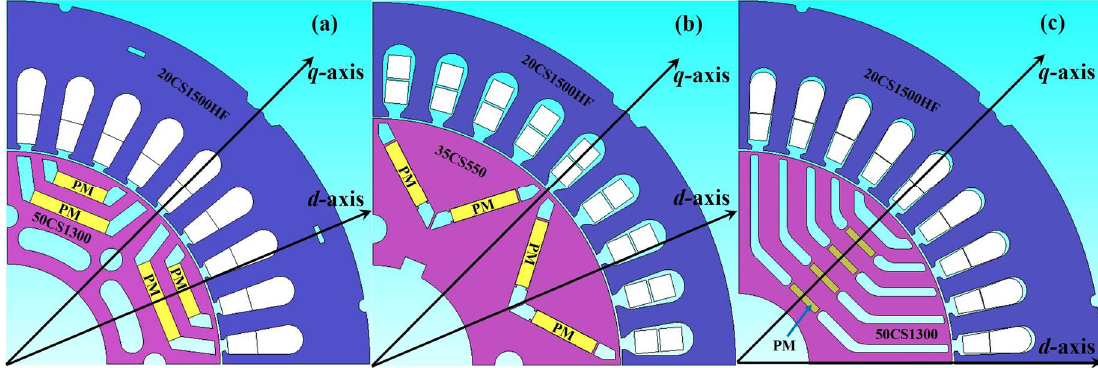
Figure 1. Traction motors using rare-earth permanent magnet (PM): ( a ) double-layers interior permanent magnet synchronous machines (IPMSM). Rotor material: 50CS1300. Stator material: 25CS1500HF; ( b ) V-shaped IPMSM. Rotor material: 35CS550. Stator material: 25CS1500HF; and, ( c ) PM-assisted synchronous reluctance motors (PMa-SynRM). Rotor material: 50CS1300. Stator material: